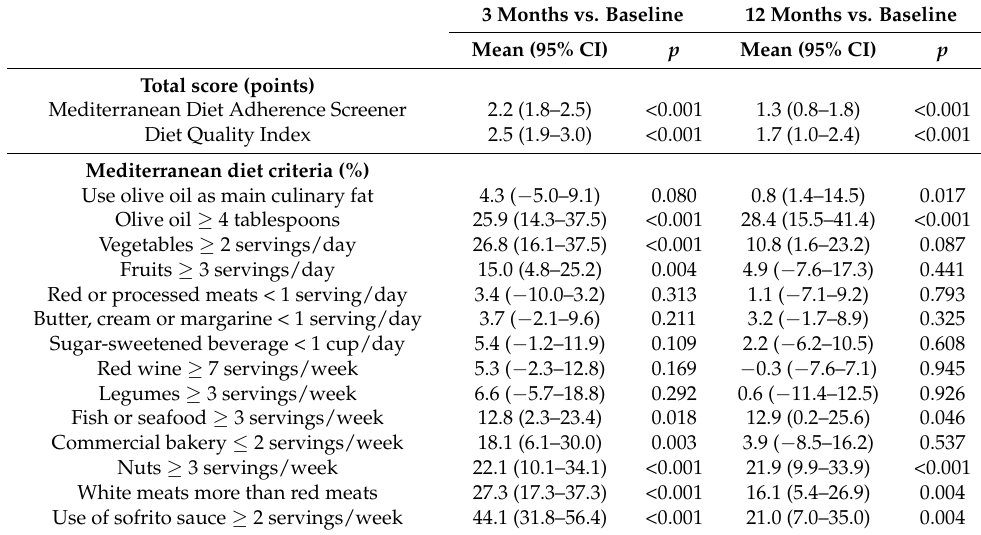
Table 3. Intergroup modifications of the diet parameters in the follow-up visits compared to the baseline visit. 3 Months vs. Baseline